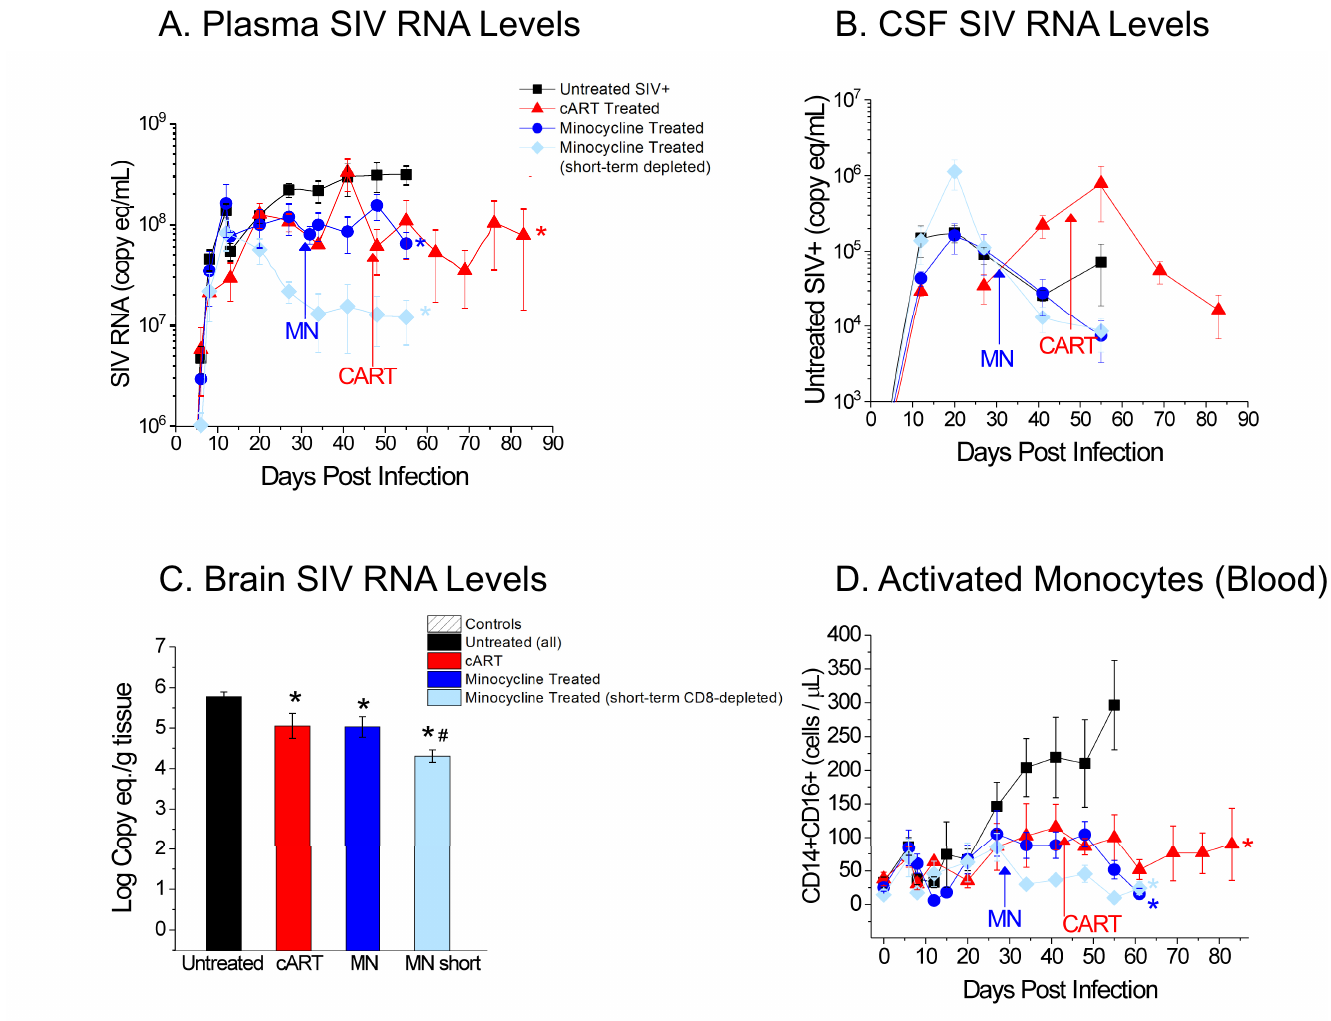
Fig 3. Viral levels in the three compartments and activated monocytes with and w/o treatment. A. Treated animals revealed lower plasma vRNA levels (~1 log) at endpoints when compared to untreated animals at 8 wpi (cART P = 0.019; MN persistent P = 0.0063). Lowest plasma SIV RNA levels (~2 log compared to untreated) were observed in animals that were minocycline treated and had partial immune reconstitution of the CD8 + T cell population (P = 0.0032). ( (cid:3) indicates statistically significant differences when compared to untreated animals.) B. Cerebrospinal fluid viral levels decreased in cART and in minocycline treated animals after endpoint, yet differences in cerebrospinal fluid viral burden failed to reach significance. C. Viral levels in cART and minocycline treated animals were lower than those in untreated animals (cART P = 0.007; MN persistent P = 0.006; MN short P < 0.0001). Short-term CD8-depleted minocycline-treated animals had significantly reduced brain vRNA levels when compared to all other cohorts, specifically in animals that were minocycline treated and CD8-depleted (P = 0.032). ( (cid:3) indicates statistically significant differences when compared to untreated animals. # indicates statistically significant differences when compared to all other cohorts.) D. The cART cohort and the minocycline treated cohort had significantly lower CD14 + /CD16 + monocytes compared to untreated at their endpoints (cART P = 0.014; MN persistent P = 0.004; MN short P = 0.0035). ( (cid:3) indicates statistically significant differences when compared to untreated animal.). https://doi.org/10.1371/journal.pone.0196949.g003 compared to untreated animals at 8 wpi (MN 6.5 x 10 7 copies eq./mL P = 0.0063, Fig persistent 3A ). The plasma viral load also appears to plateau as therapy is begun. In the animals who had early CD8+ T cell recovery and who were treated with MN, there was a decline from peak viral load levels to a new plateau that was nearly two orders of magnitude lower than that of untreated animals (MN 1.2 x 10 7 copies eq./mL P = 0.0032, Fig 3A ). CSF vRNA was short decreased in MN treated animals (MN : 7.5 x 10 3 copies eq./mL and MN : 8.6 x 10 3 persistent short copies eq./mL) at endpoint compared to untreated animals at 8 wpi (7.2 x 10 4 copies eq./mL);